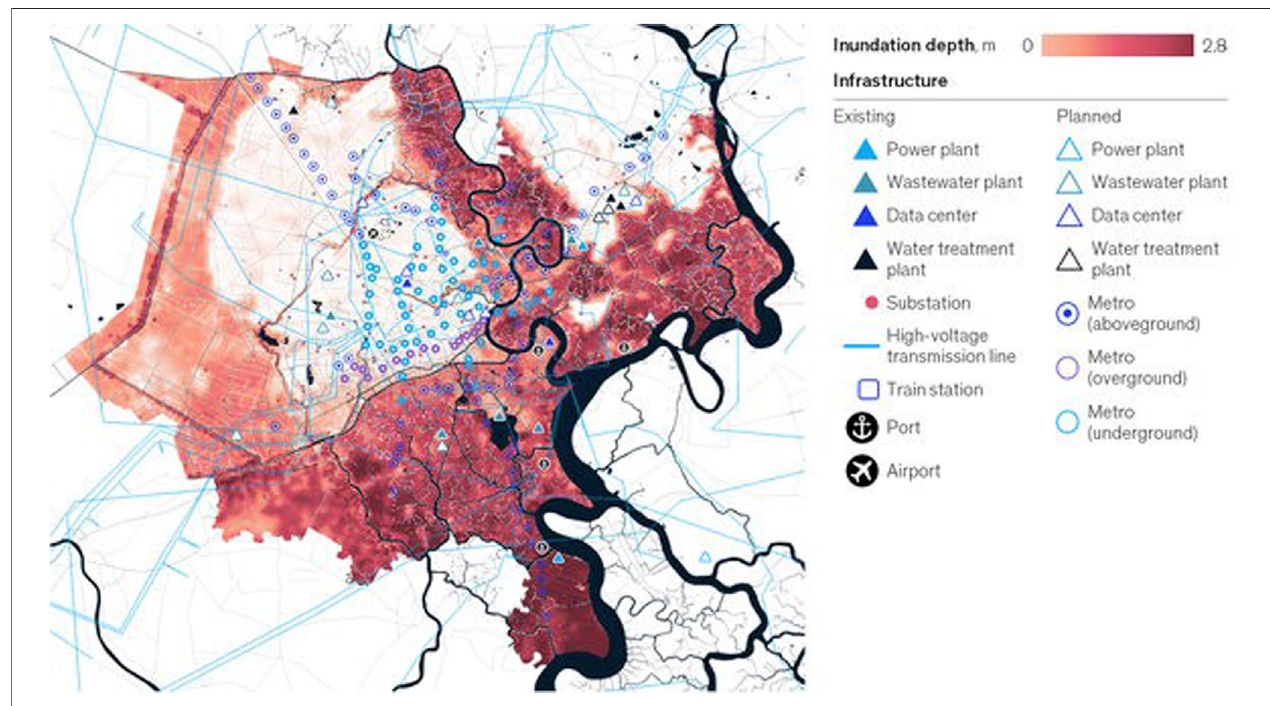
FIGURE 2 | Inundation map of the Binh Chanh district.